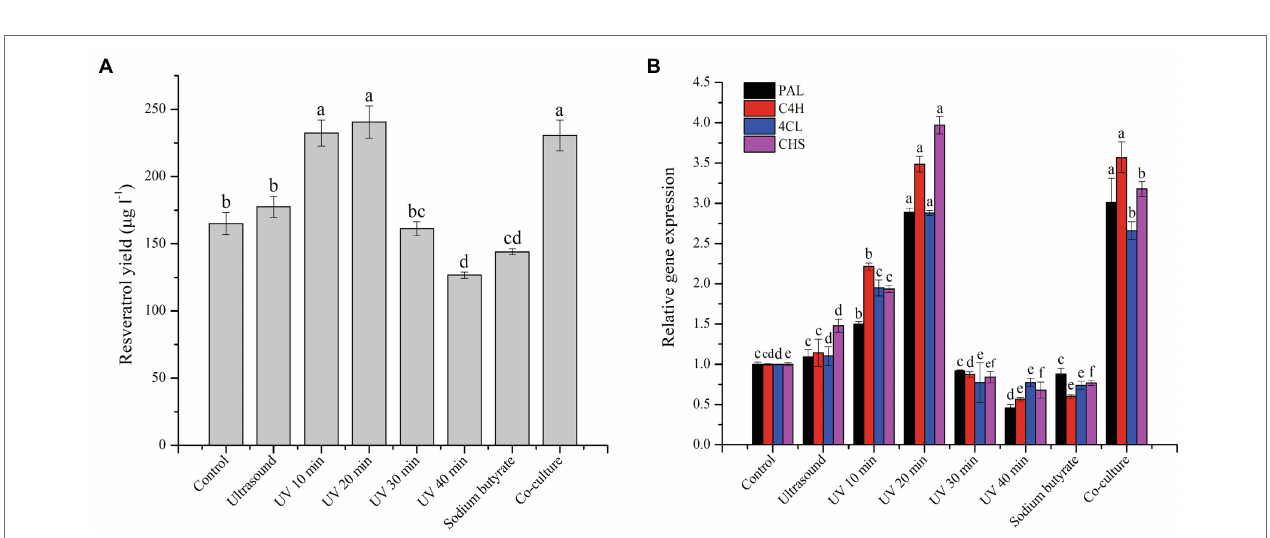
FIGURE 1 | Determination of resveratrol in the culture of Alternaria sp. MG1. HPLC chromatogram of resveratrol standard (A) . HPLC chromatogram of the resveratrol detected in control group of MG1 (B) .